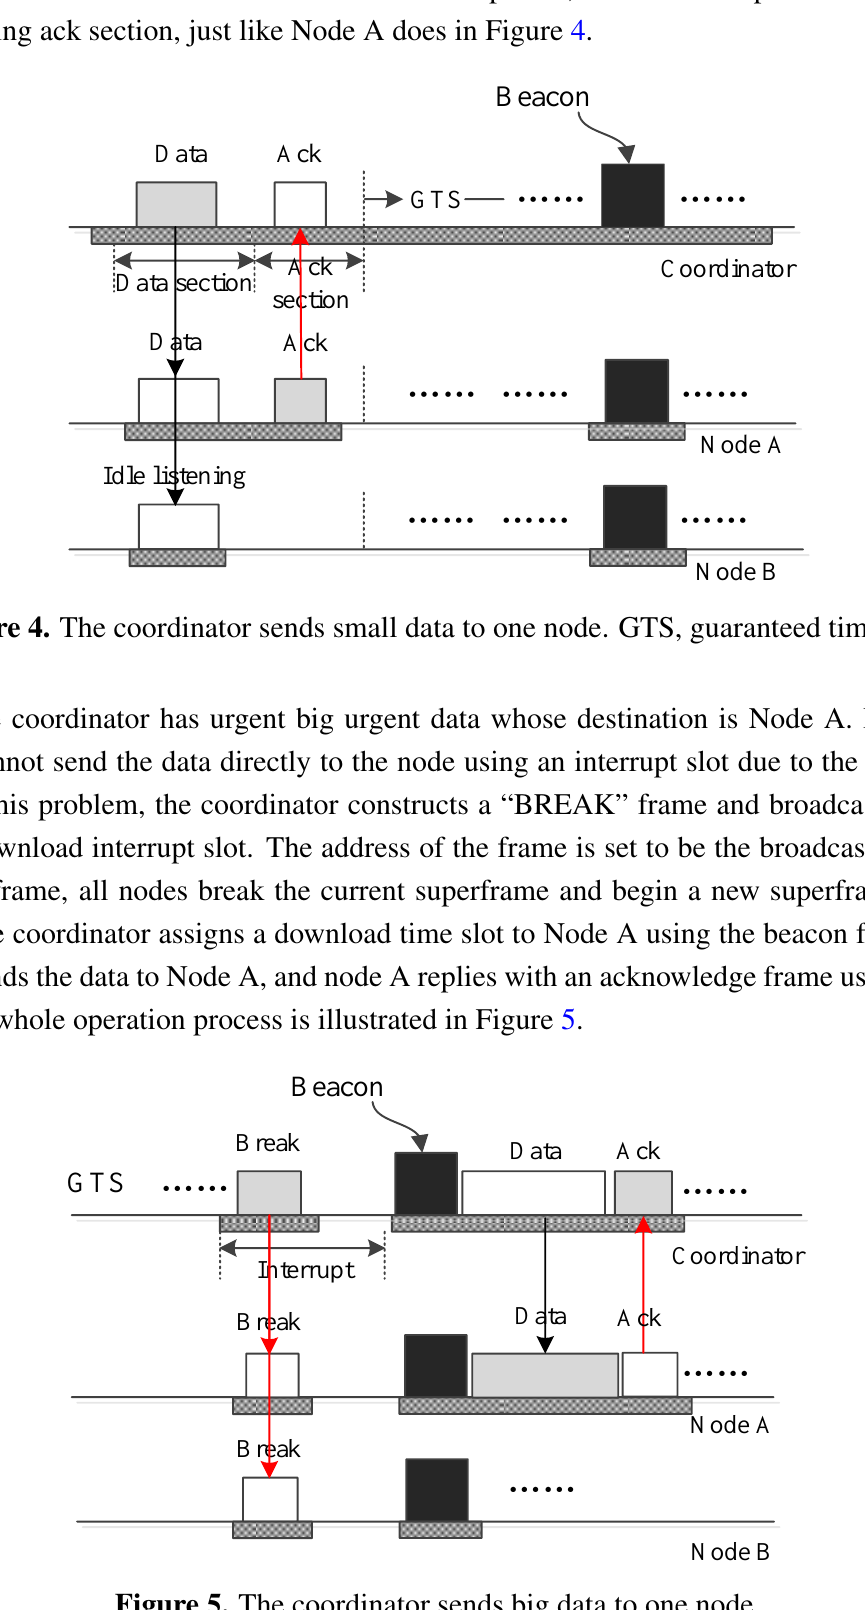
Figure 5. The coordinator sends big data to one